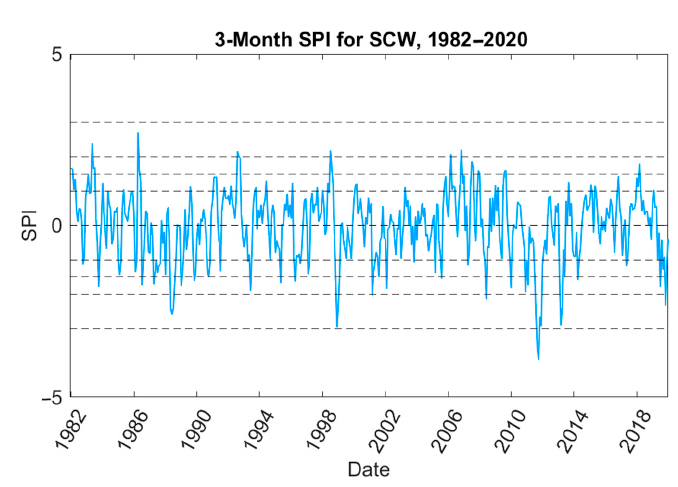
Figure A6. 3 ‐ Month SPI from 1982 to 2020. Figure A6. 3-Month SPI from 1982 to